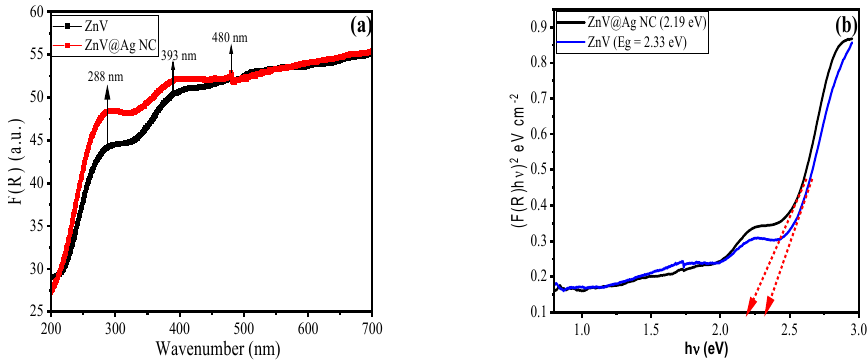
Figure 6. UV ‐ vis reflectance spectra ( a ) and band ‐ gap plot ( b ) of ZnV and ZnV@Ag NC. Furthermore, we also used the XPS technique to identify the existence of the valence state of Ag in the synthesized ZnV@Ag sample. The XPS survey scan of ZnV@Ag NC is shown in Figure 7a. The survey spectrum of ZnV@Ag shows the presence of Ag3d, V2p, Zn2p, and O1s, which suggested that ZnV@Ag had been formed. The presence of binding energies at ~1023 eV and 1046 eV is attributed to Zn2p 3/2 and Zn2p 1/2 of Zn 2+ , respectively (Figure 7b). According to the high ‐ resolution V2p spectrum, the appearance of two peaks at binding energy values of 522.5 and 515.7 eV can be ascribed to V2p 5/2 and V2p 3/2 of V 5+ in ZnV, respectively (Figure 7c). The presence of two peaks at binding energies of 365.4 and 372.4 eV can be assigned to Ag3d 5/2 and Ag3d 3/2 , respectively (Figure 7d). The obtained high ‐ resolution XPS spectrum of Ag3d suggested the presence of metallic Ag (0). Figure 7e shows the O1s spectrum of ZnV@Ag, and the presence of a peak at the binding energy value of 528.34 eV can be assigned to the presence of lattice oxygen in the ZnV@Ag sam ‐ ple. The XPS results for ZnV@Ag are well matched with the published literature [31].